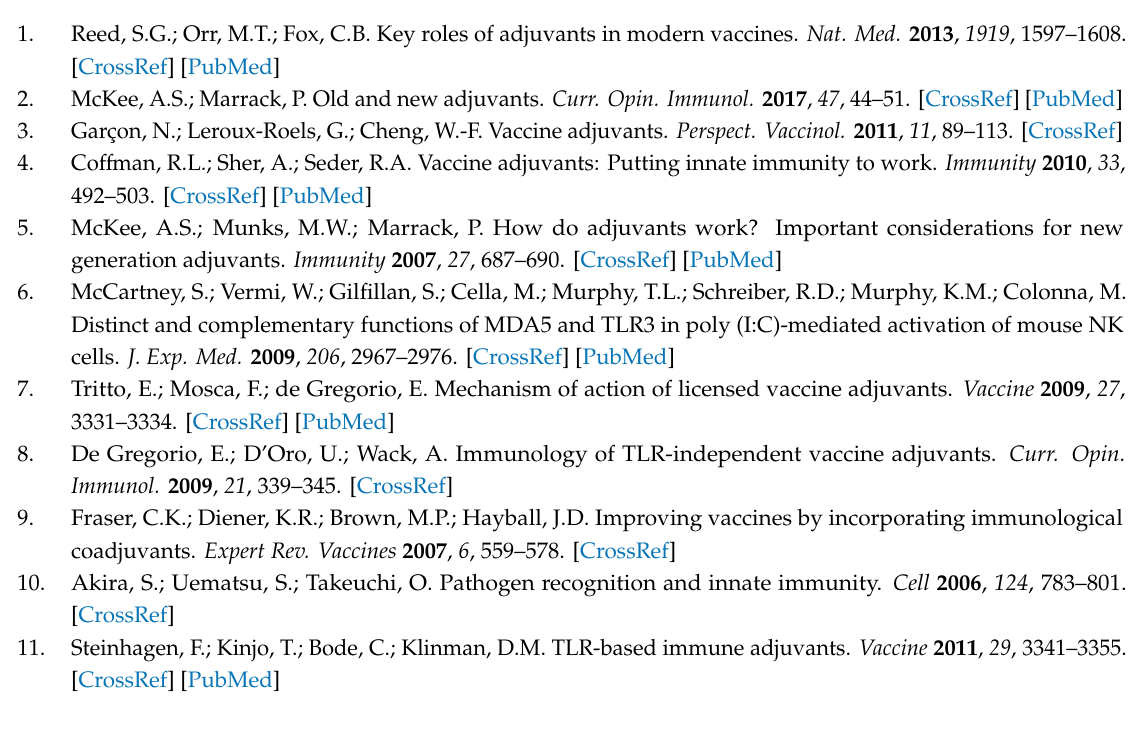
Figures S1–S12: Showing a representative 4-parameter logistic plot of TNF- α , IL-1 β , IL-6, and IL-10 standard samples, Figure S13: Changes in metabolites by treatments and LPS when compared with untreated control, Tables S1–S4: E ff ect of eicosenoid compounds on the production of TNF- α , IL-1 β , IL-6, and IL-10 cytokines in the presence and absence of LPS, Table S5: Additional changed non-polar metabolites in THP-1 cells, Table S6: List of abbreviation, Table S7: List of catalog / serial number of instruments and